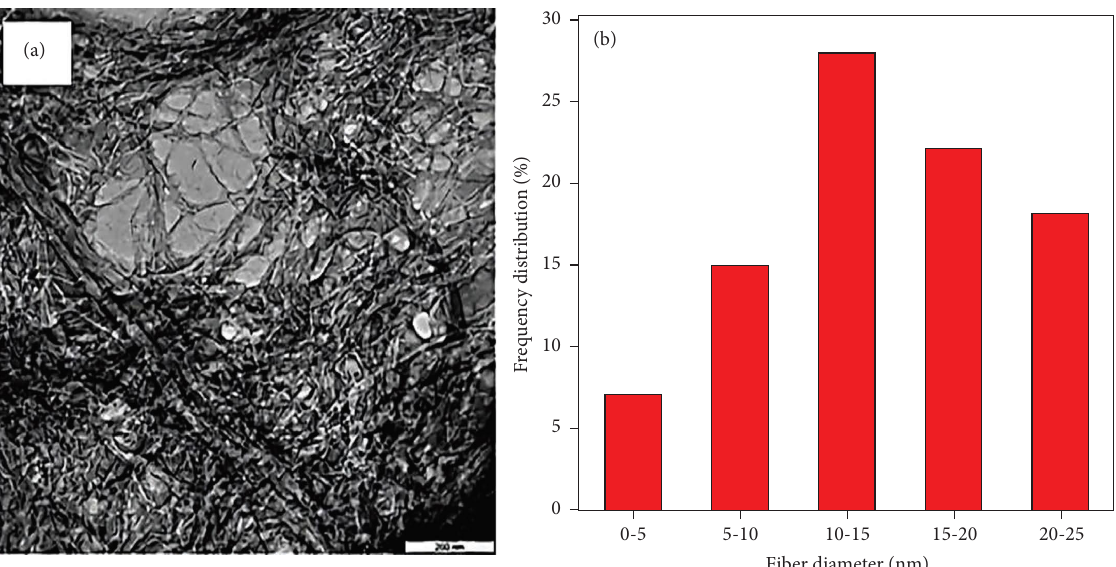
Figure 9: TEM imaging of (a) kenaf CNFs in the inset scale of 200 nm and (b) fber diameter in nm. TEM result analysis shows that the kenaf CNFs has the diameter of 10–15nm according to the frequency distribution [166]. Copyright and permission from MPDI-2019.